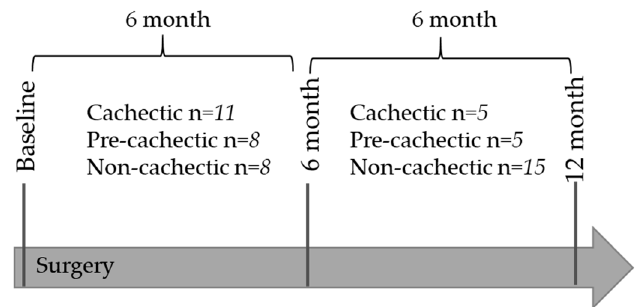
Figure 1. Classification of patients into the three groups: Between baseline and 6 months, and between 6 months and 12 months. 6 months and 12